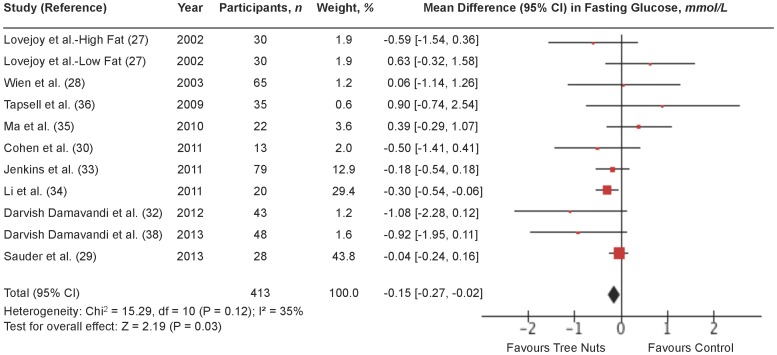
Forest plot of randomized controlled trials investigating the effect of diets supplemented with tree nuts on fasting glucose in individuals with type 2 diabetes.Pooled effect estimate (diamond) for fasting glucose (mmol/L). Data are expressed as weighted mean differences (MD) with 95% CIs, using the generic inverse-variance fixed effects model. Paired analyses were applied to all crossover trials. Inter-study heterogeneity was tested by the Cochran Q-statistic and quantified by I2 at a significance level of P<0.10. n = number of participants in each treatment group.